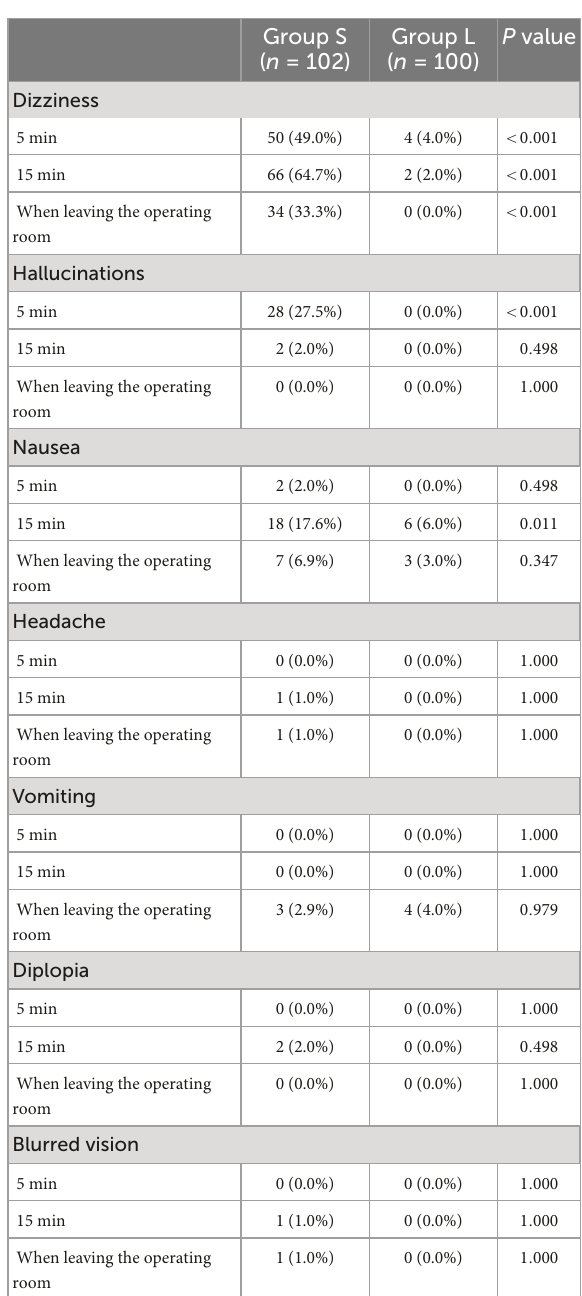
TABLE 3 Adverse effects in patients between two